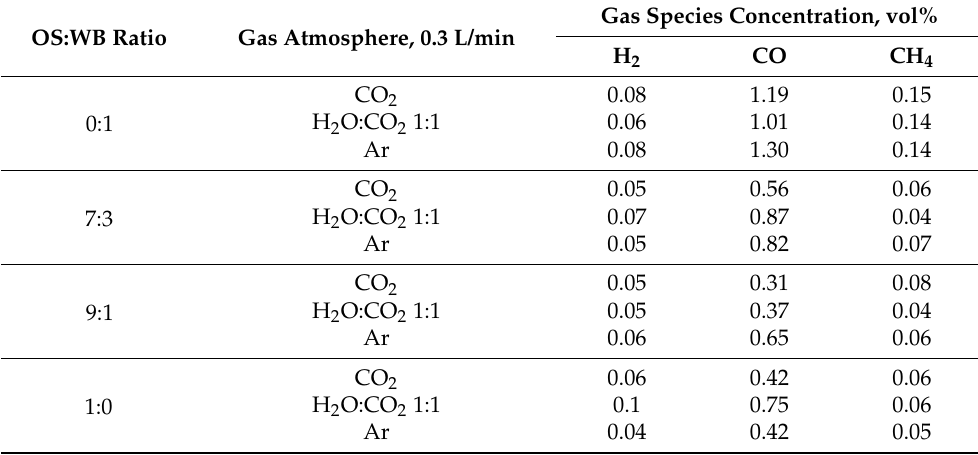
Table 2. Concentration of H 2 , CO, and CH 4 in the co-pyrolysis